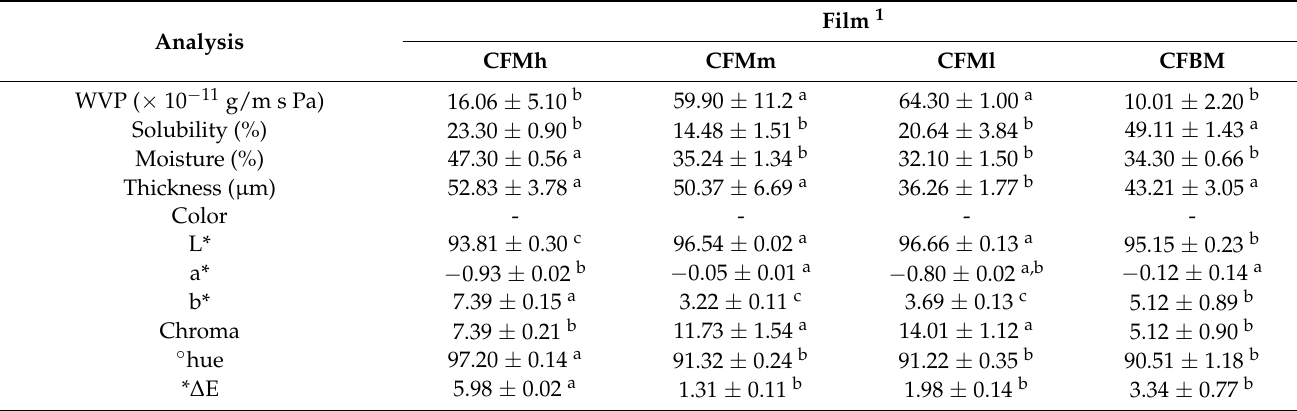
Table 1. Results of water vapor permeability (WVP), solubility, moisture, thickness and color, obtained from the evaluation of Brachystola magna and commercial chitosan films